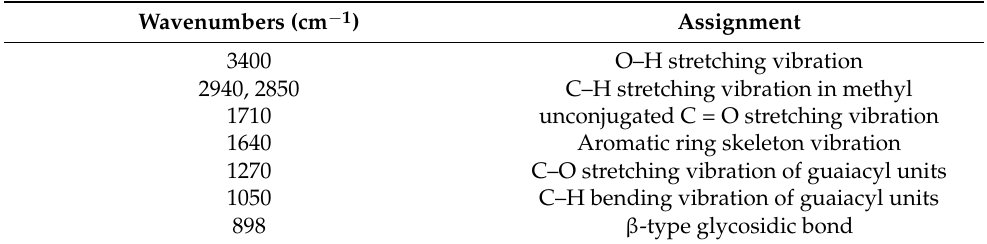
Figure 4. FT-IR spectra of oxygen-delignificated kraft pulps and the extracted lignin with or without IL pretreatments: ( a ) FT-IR spectra of oxygen-delignificated pulps: (A) control pulp, (B) [BMIM][HSO 4 ] pretreated pulp, and (C) [TEA][HSO 4 ] pretreated pulp; ( b ) FT-IR spectra of lignin extracted from oxygen-delignificated pulps: (A) lignin in control pulp, (B) lignin in [BMIM][HSO 4 ] pretreated pulp, and (C) lignin in [TEA][HSO 4 ] pretreated pulp. Table 5. Assignment of FT-IR spectra of oxygen-delignificated kraft pulps and the extracted lignin with or without IL